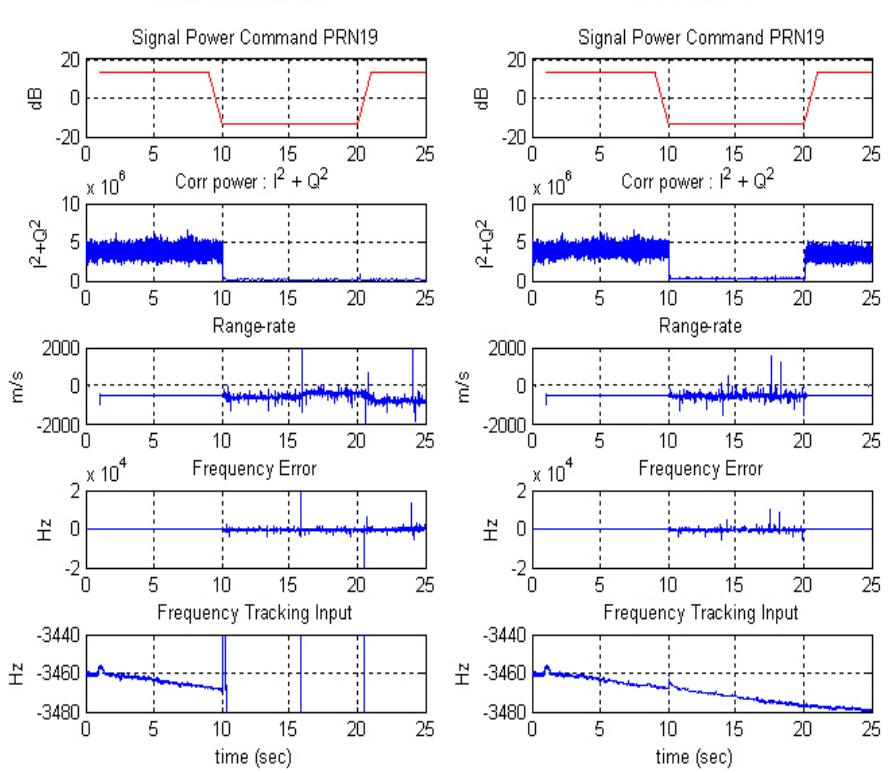
Figure 12. Code tracking result of PRN 19: Independent FLL (left) and Vector FLL